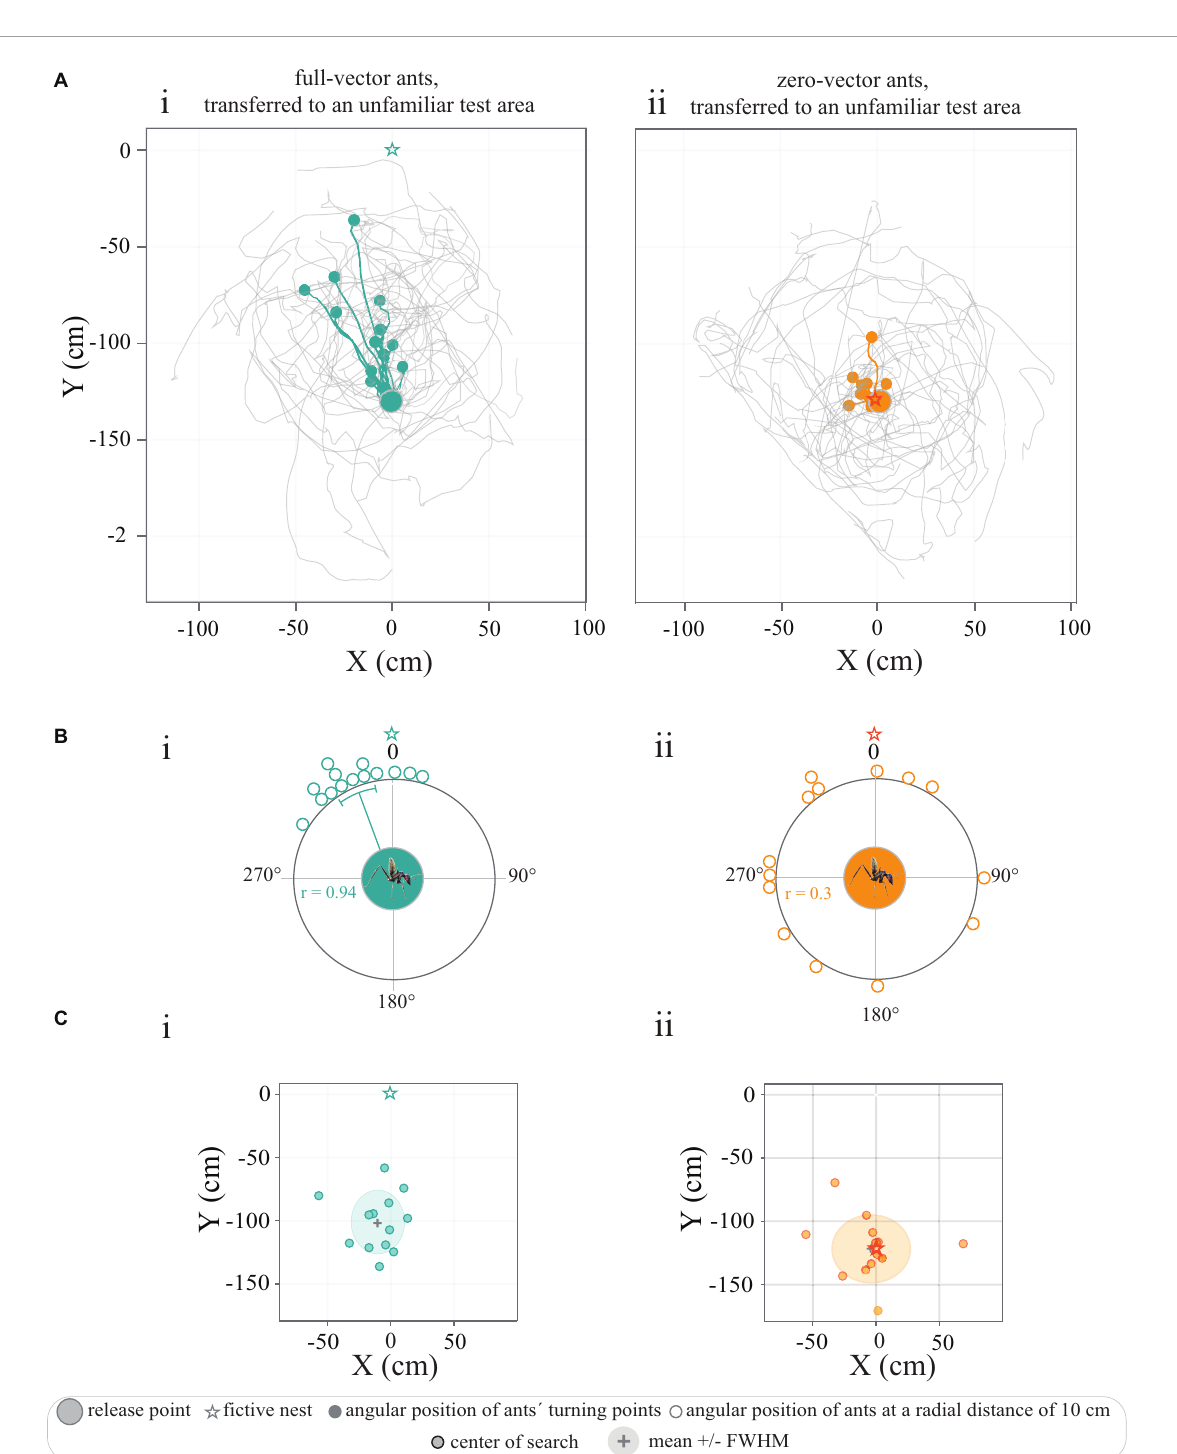
FIGURE3 Tracks of full-vector and zero-vector ants transferred to an unfamiliar test area. (A) Trajectories represent the paths of ants caught (i) at the feeder (full-vector ants, green) or (ii) just before they entered their nest (zero-vector ants, orange). Colored trajectories illustrate the paths of individual ants until their turning point (filled circles). Gray paths illustrate their search after the turning point. (Bi–iii) Circular graphs represent the angular positions of ants at a radial distance of 10 cm away from the release point in relation to the normalized fictive nest direction (0 ◦ ). And colored line within the circular graphs indicate mean angles, and the associated sectors represent the 95% confidence interval of the mean. r represents mean vector length. (C) The center of the search paths described with respect to the location of the fictive nest (star). Gray crosses and shaded colored areas mark the mean and the full width at half maximum (FWHM) of the